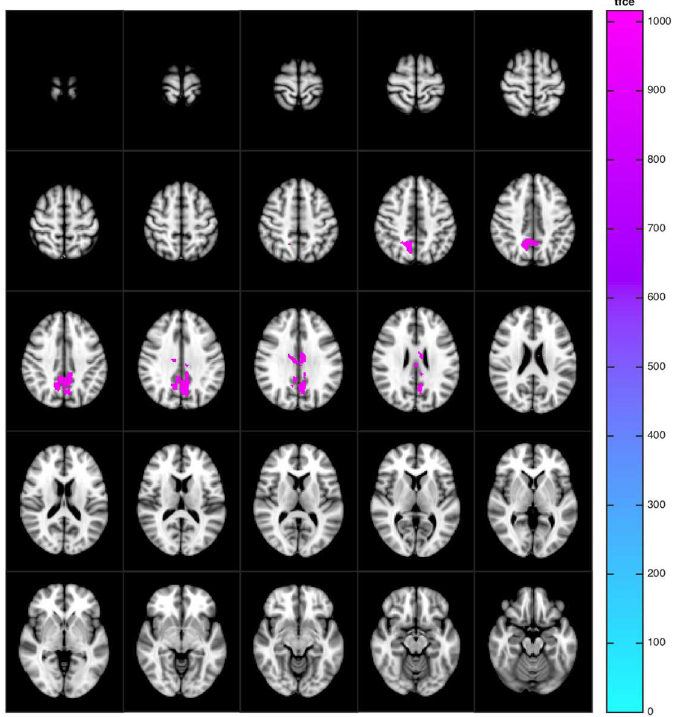
Fig 3. The relationship of group with regional cerebral blood flow. Voxels in absolutecerebralblood flow maps with significant(p < 0.05,corrected for multiplecomparisons) negativecorrelationwith group (Group B < Group A), adjustedfor homocysteine and